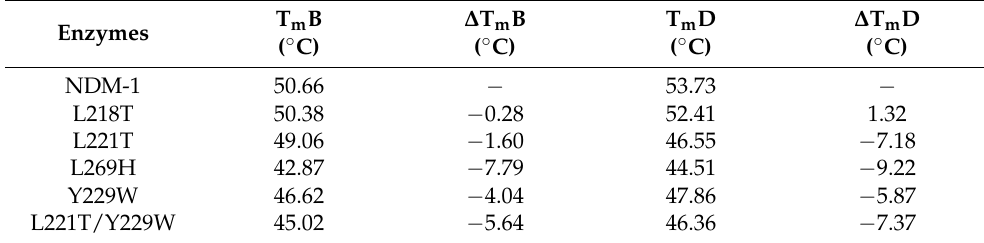
Table 3. Effect of replacements L218T, L221T, L269H, Y229W and L221T/Y229W on thermal stability (T m ) of NDM-1. Enzymes